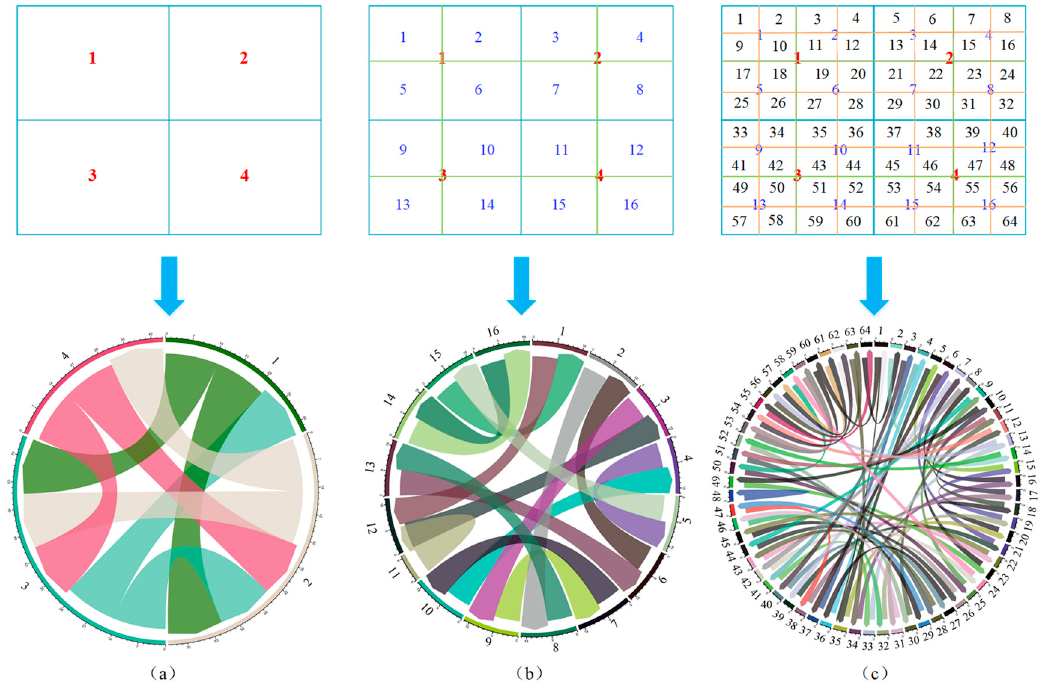
Figure 5. The expression of space multiscale for OD data.